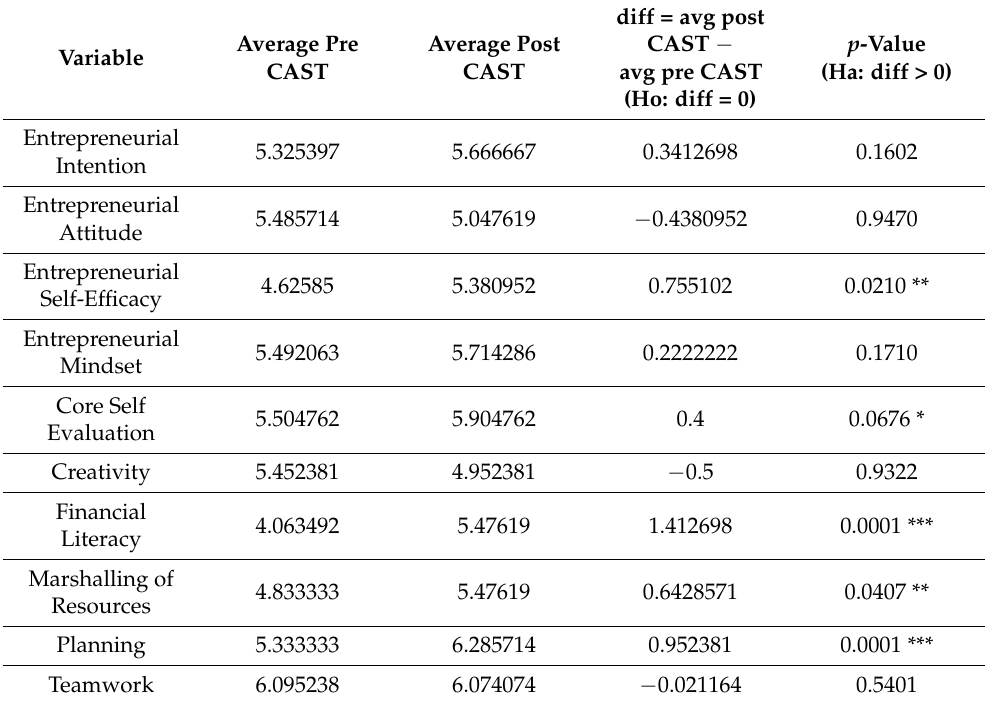
Table A2. Output of t -tests on entrepreneurial characteristics, pre- and post-course, of the male students.